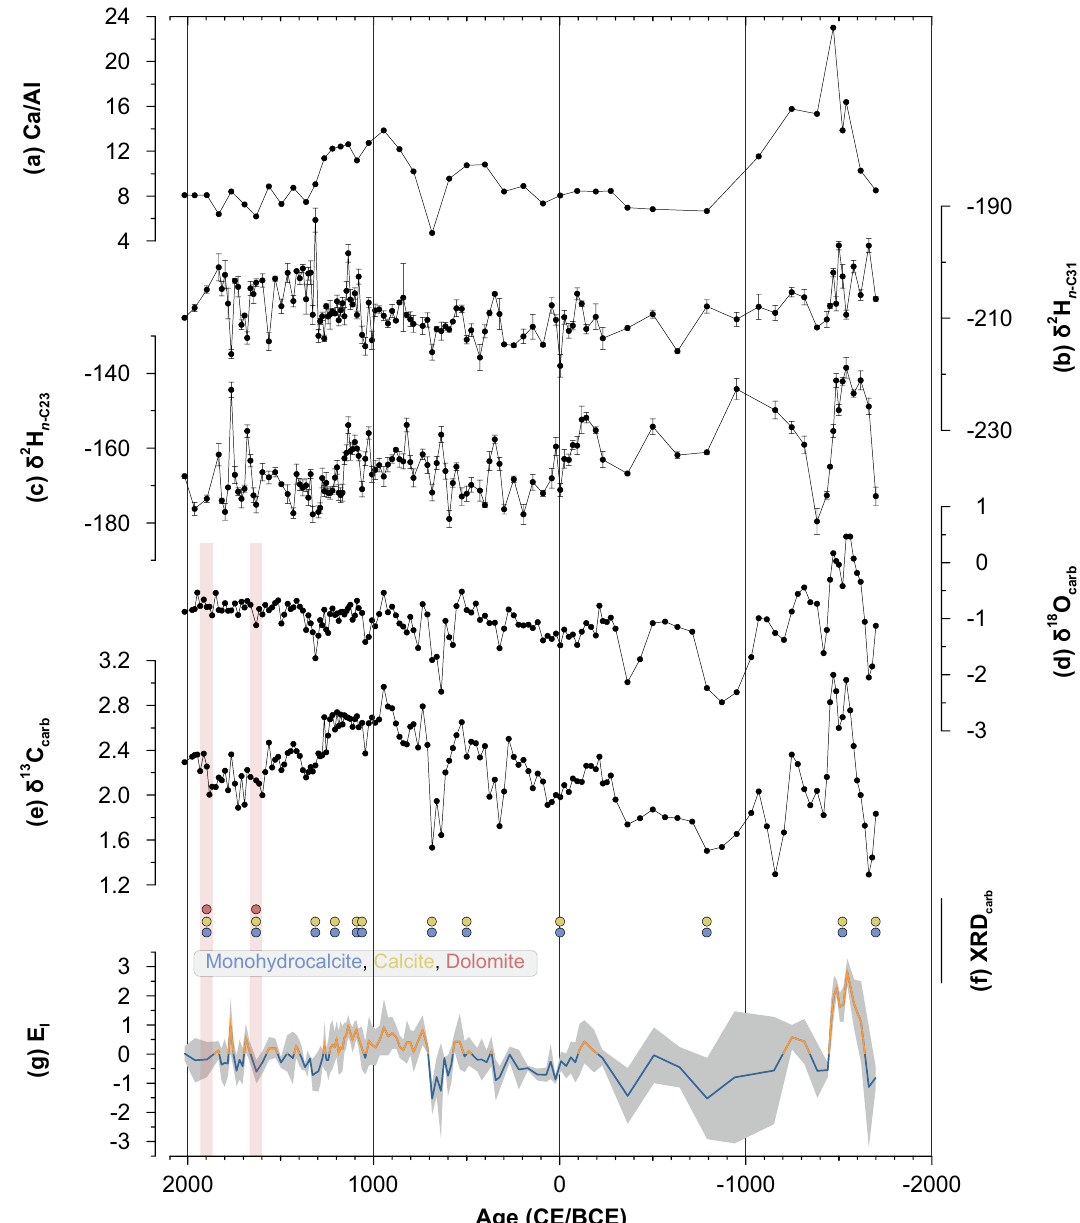
Figure 3. Geochemical and isotope records for the sediment core from Lake Telmen. ( a ) The Ca/Al ratio [–], ( b ) compound-specific δ 2 H n -C31 [‰ vs. VSMOW], ( c ) compound-specific δ 2 H n -C23 [‰ vs. VSMOW], ( d ) bulk carbonate δ 18 O [‰ vs. VPDB], ( e ) bulk carbonate δ 13 C [‰ vs. VPDB], ( f ) carbonate mineral forms; monohydrocalcite (blue), calcite (yellow), and dolomite (red). Red bars emphasize the occurrence of dolomite and a potential influence on bulk carbonate δ 18 O and δ 13 C, and ( g ) evaporation index (E I ) [–], yellow = dry, blue = humid, gray-shaded area = standard